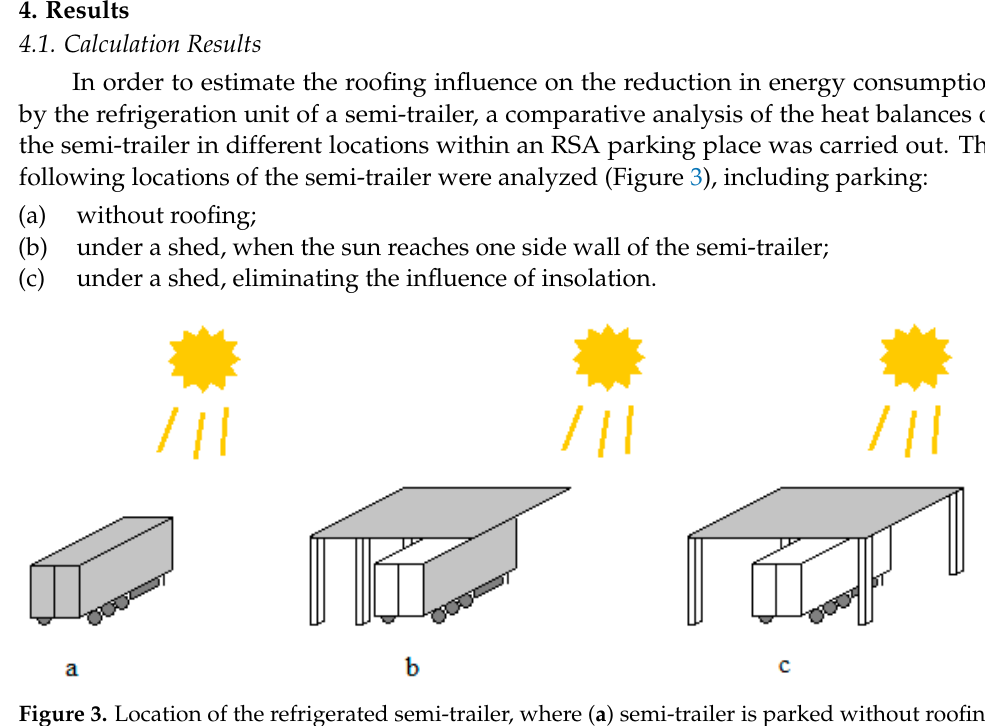
Table 1. Heat exchange surface of the exemplary refrigerated semi-trailer.